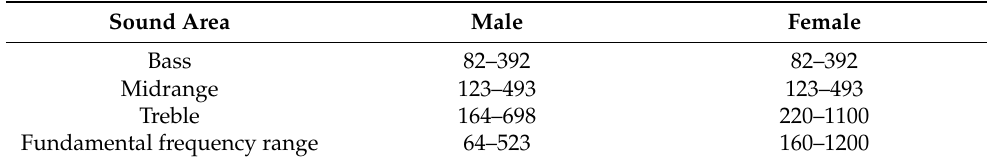
Table 1. Frequency range of common speech